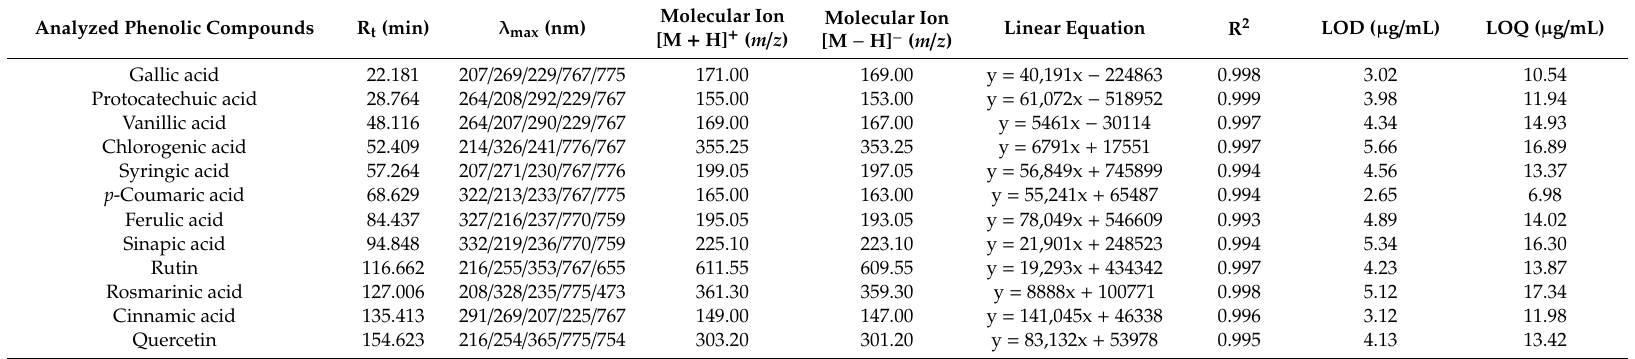
Table 5. Analytical data: retention time (R t ), analytical wavelength ( λ max ), mass spectral data and validation parameters: linear equation, correlation coe ffi cient (R 2 ), limit of detection (LOD) and limit of quantification (LOQ) of the calibration curves for LC-DAD-ESI / MS